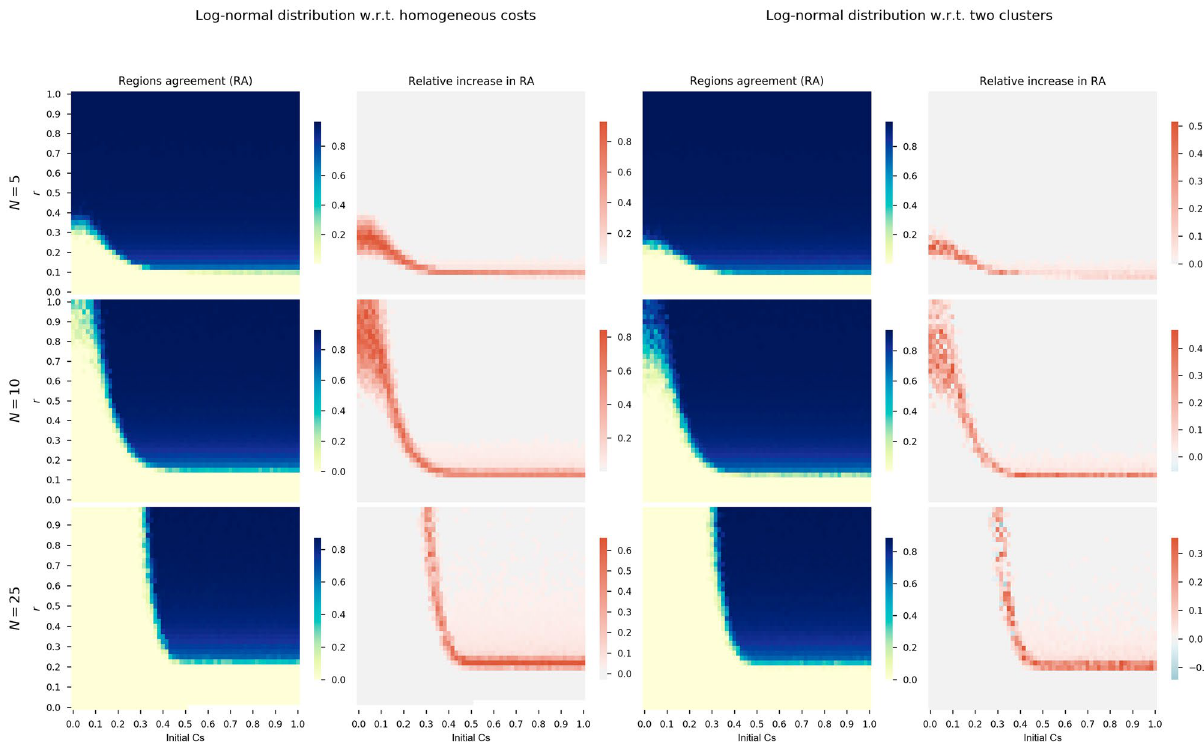
Figure 4. First and third columns show heatmaps of absolute RA when considering equal global costs and two groups of regions, respectively. The second column shows relative RA differences when using log-normal distribution costs with respect to equal costs for all the regions. Fourth column shows heatmaps with relative RA differences of log-normal distribution costs with respect to two clusters of regions. Each row of the panel shows results for different group sizes ( N ) and m = 0.5